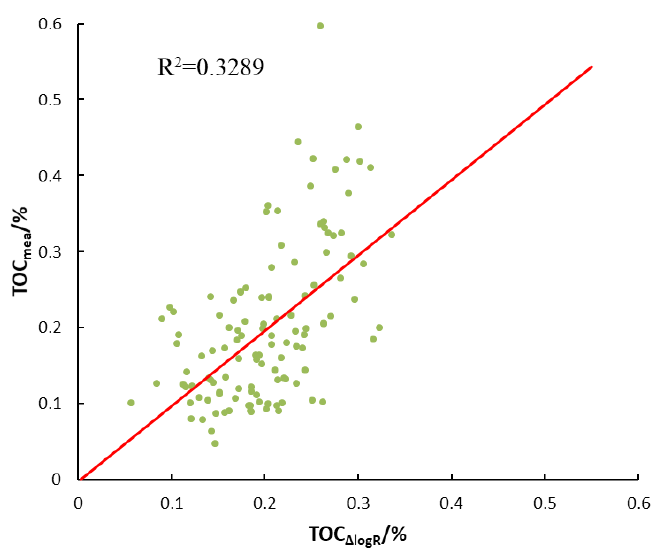
Figure 6. Scatter plot of predicted TOC and measured TOC by ΔLogR m ethod.